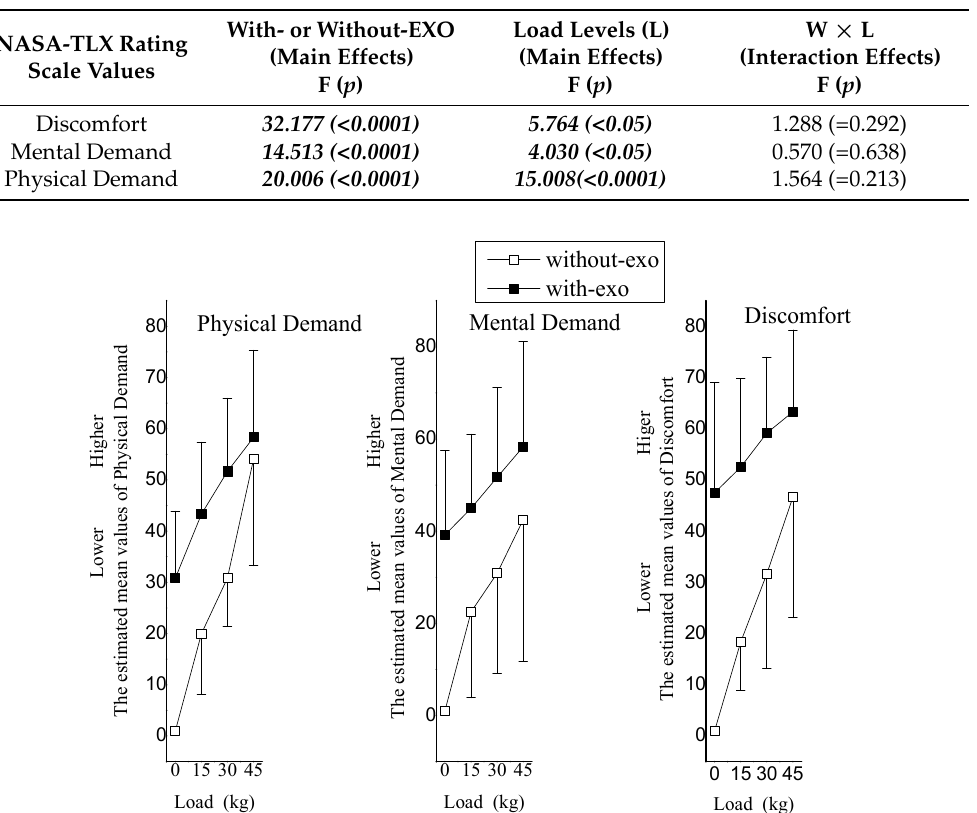
Figure 12. The interaction trend plot of with-Exo or without-Exo × load level.